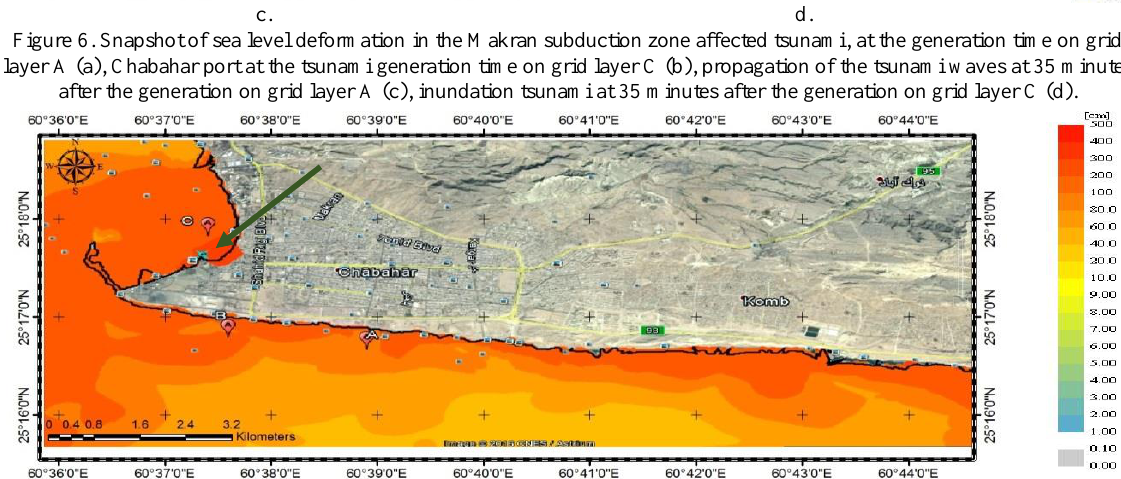
Figure 7. Maximum waves amplitude recorded during a two-hour simulation in the Chabahar port. The maximum wave amplitude is 3 meters (assigned by arrow), and the maximum inundation area is 1.2 Km 2